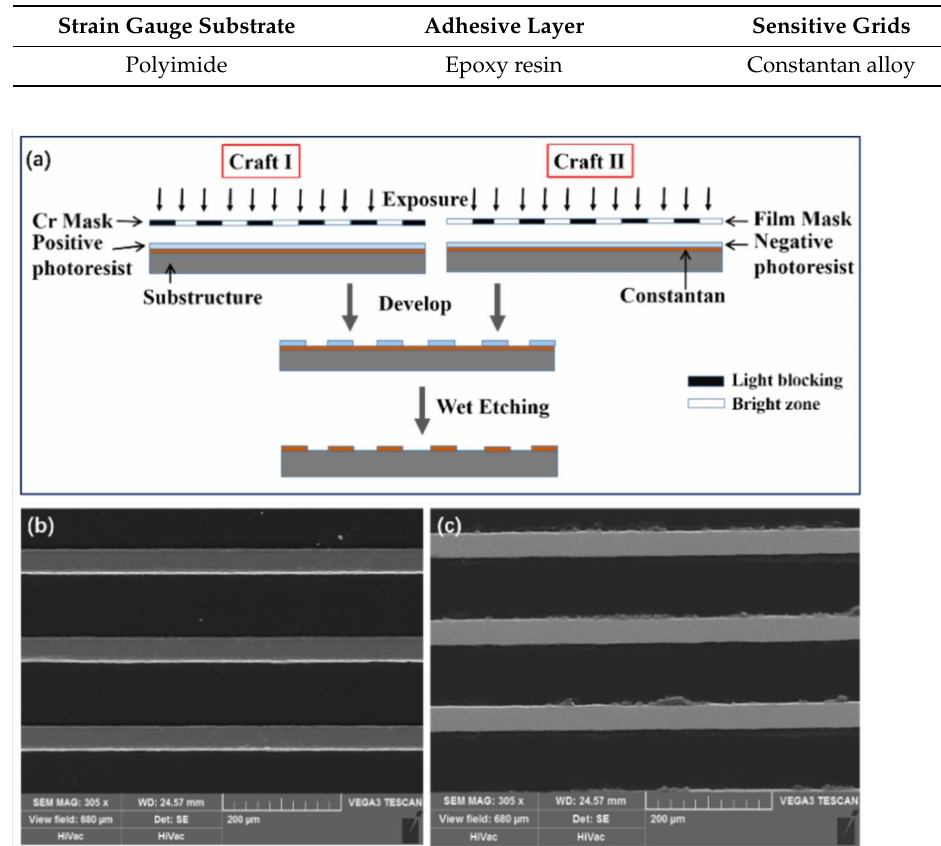
Table 3. Materials of the main layers of strain gauges used in the experimental test.